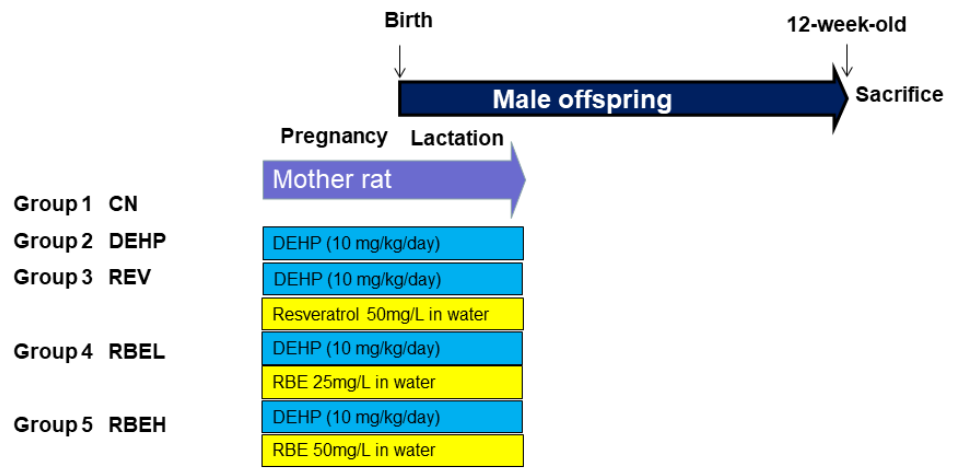
Figure 1. Experimental protocol used in the current study. CN = control; DEHP = Mother rats received di-2-ethylhexylphthalate (DEHP); REV = Mother rats received DEHP and resveratrol supplementation; RBEL = Mother rats received DEHP and low dose resveratrol butyrate ester (RBE); RBEH = Mother rats received DEHP and high dose RBE.